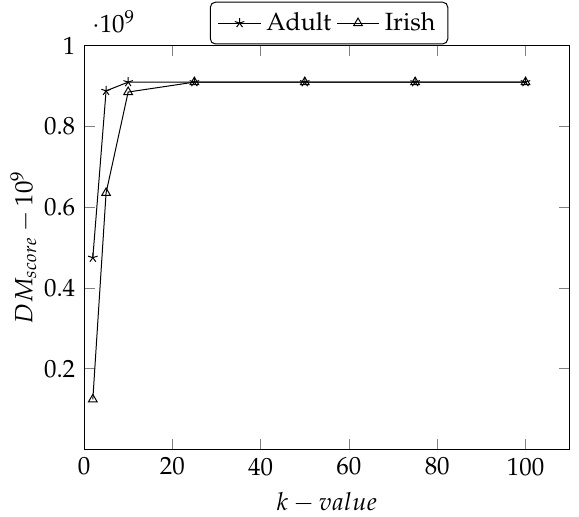
Figure 14. DM Performance of Utility.